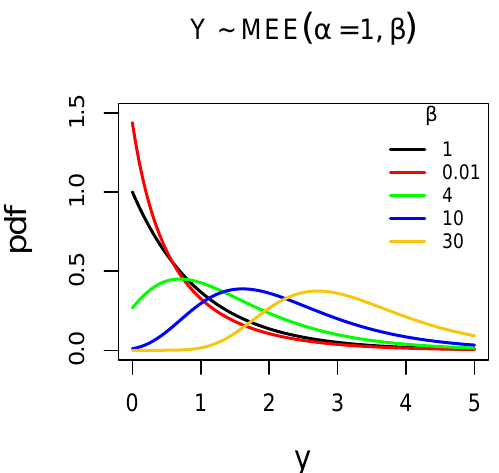
Figure 1. Plots of the MEE distribution pdf for different values of parameter β .